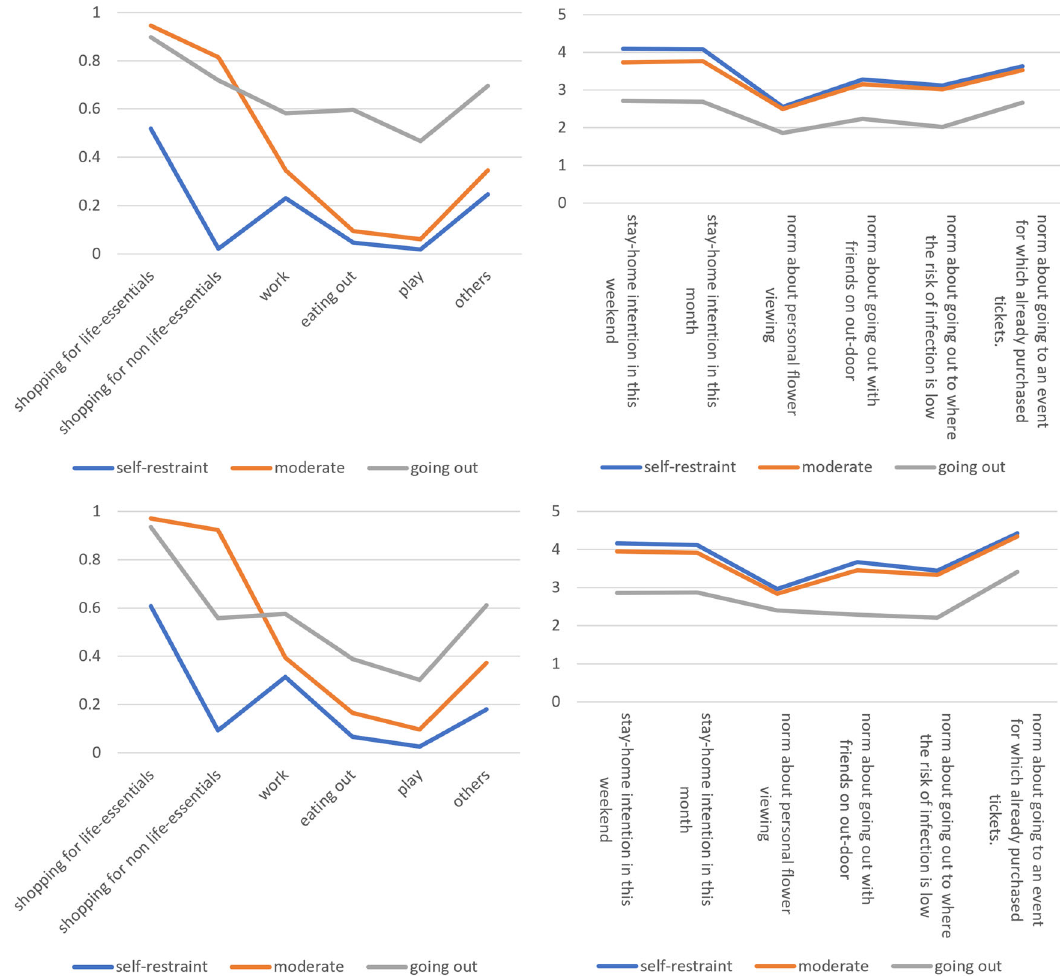
Fig. 1 Cluster centres. Larger values are more self-restrained. Top: 2020; Bottom: 2021; Left: Percentage of going out for each purpose during previous weekend; Right: Stay-home intentions and preventive norms.